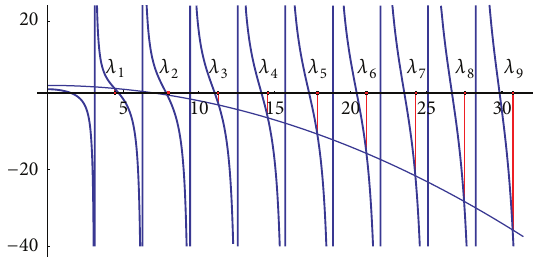
Figure 1: Graphical representation of 𝑦 = 𝜆 cot (𝜆) and determina- tion of the eigenvalues 𝜆 𝑛